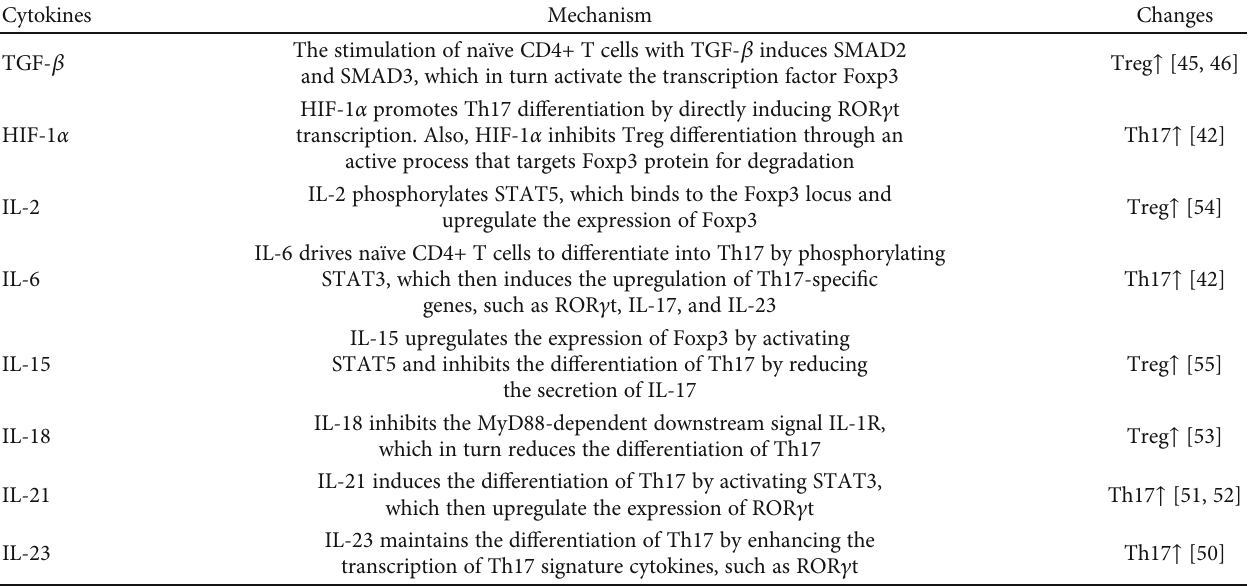
Table 1: The role of cytokines in Th17/Treg